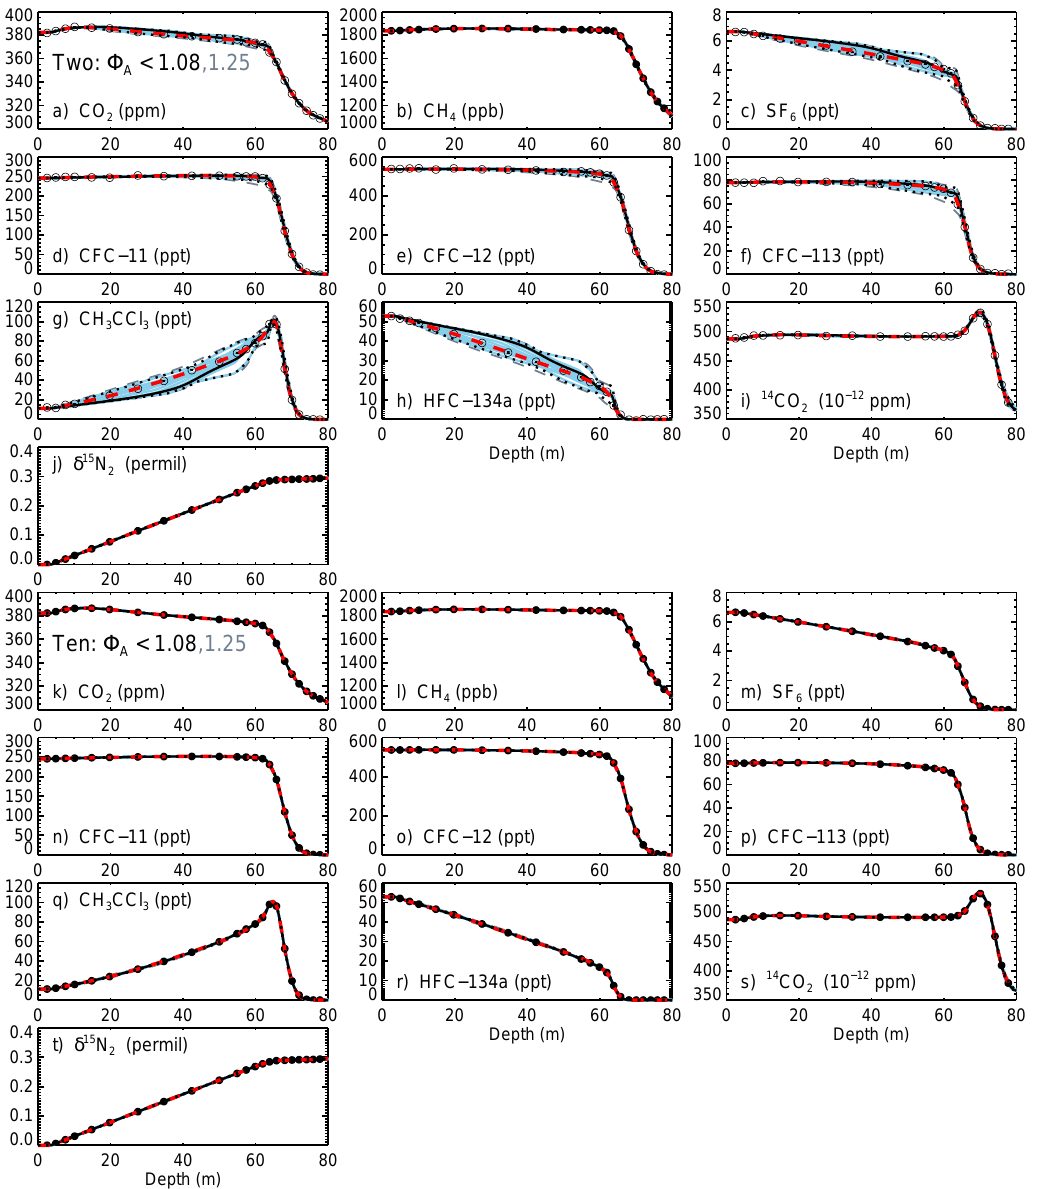
Fig. 2. Modelled concentrations for all ten tracers, where diffusivity was calibrated using Synthetic A observations of only CH 4 and δ 15 N 2 (Subset Two) (a–j) , and using all ten tracers (Subset Ten) (k–t) . The black solid line is the solution with the lowest 8 A , black dotted lines show upper and lower ranges of all accepted solutions ( 8 A < 1 . 08), the blue lines are 19 representative solutions and the red dashed line shows the true solution. The grey dashed lines show the upper and lower ranges of all solutions with 8 A < 1 . 25. Observations used to tune diffusivity are shown with filled circles, observations not used in the GA are shown by open circles. Error bars for the observations (1 σ ) are plotted but are too small to see relative to the